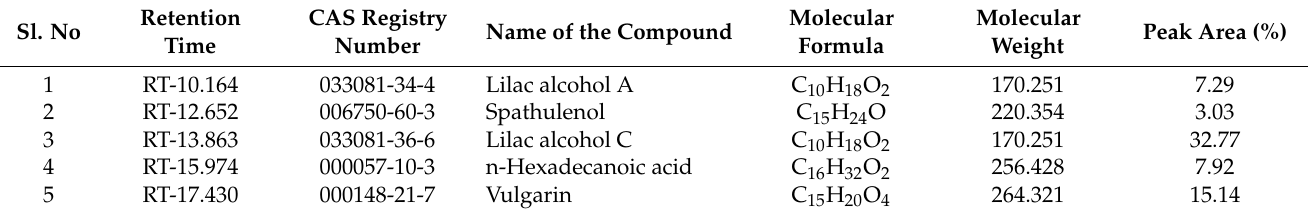
Figure 1. GC-MS chromatogram of ethanolic extract of Artemisia pallans . X -axis depicts time (in minutes) and Y -axis indicates abundance (in millivolts). Table 1. Selected bioactive compounds of A. pallens (GC-MS analysis).